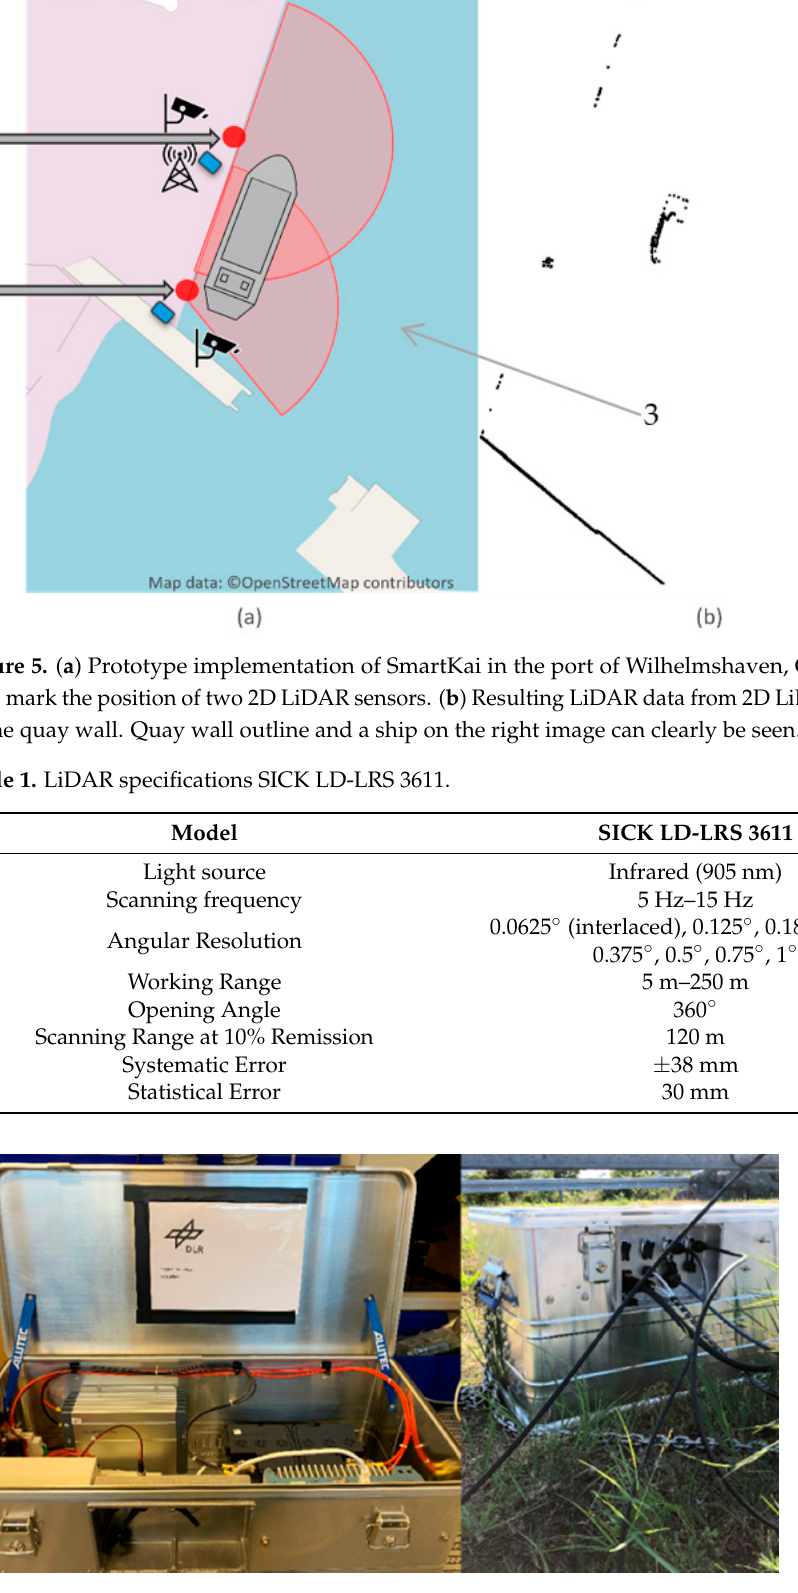
Figure 6. Sensor processing unit with battery backup that records the data from the LiDAR sensors together with various other sensors, such as AIS, camera, and weather-related information, and also communicates processed information via the mobile